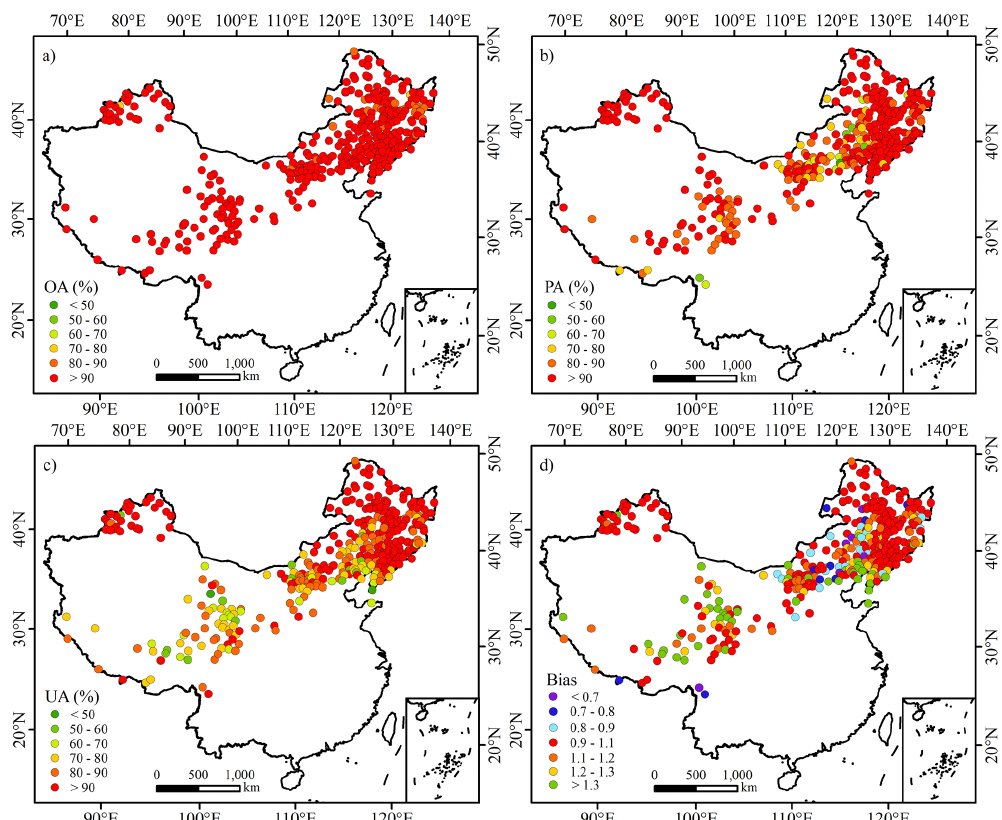
Figure 9. Accuracies of the Terra-MODIS SCE dataset at each CMA station: (a) OA, (b) PA, (c) UA, and (d) Bias.